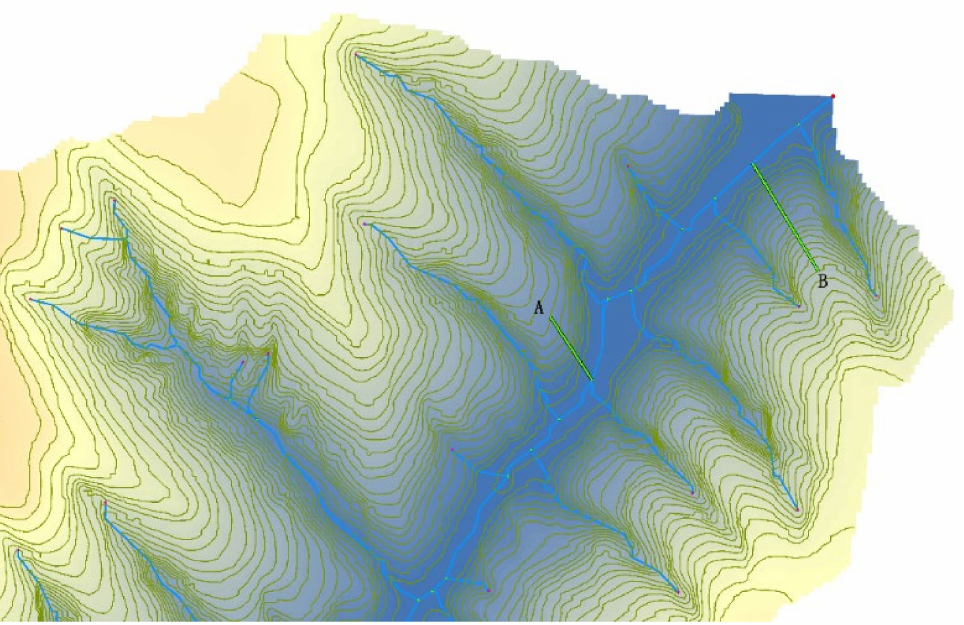
Figure 4. The diagram of the remaining parallel river networks. It is widely accepted that the true gully line should be in the direction of the projecting contour lines just as the blue gully lines in the figure. Based on this, the green line A and B can be determined as the remaining parallel river